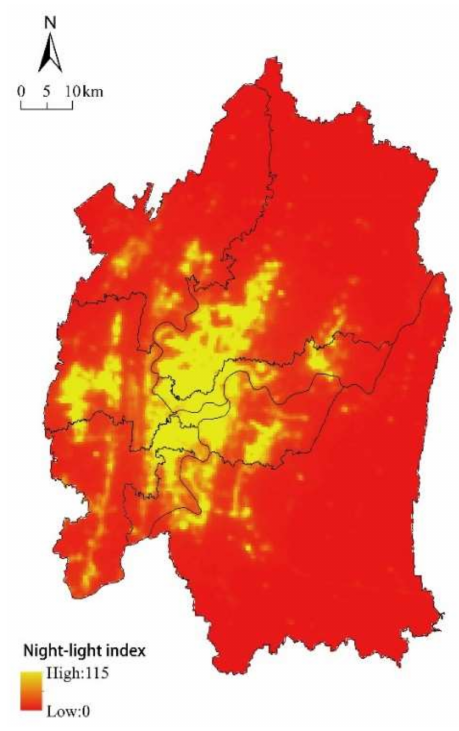
Figure 3. Nighttime light intensity in 2015. Table 2. Assessment results of supply for ecosystem